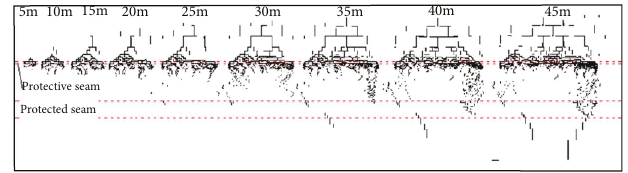
Figure 7: Floor fracture depth diagram with the di ff erent advancing distance.